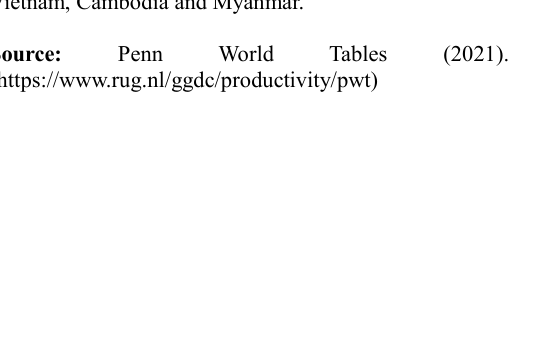
Figure 4. Human Capital Index *SCEME: without Uzbekistan, Azerbaijan, Belarus,